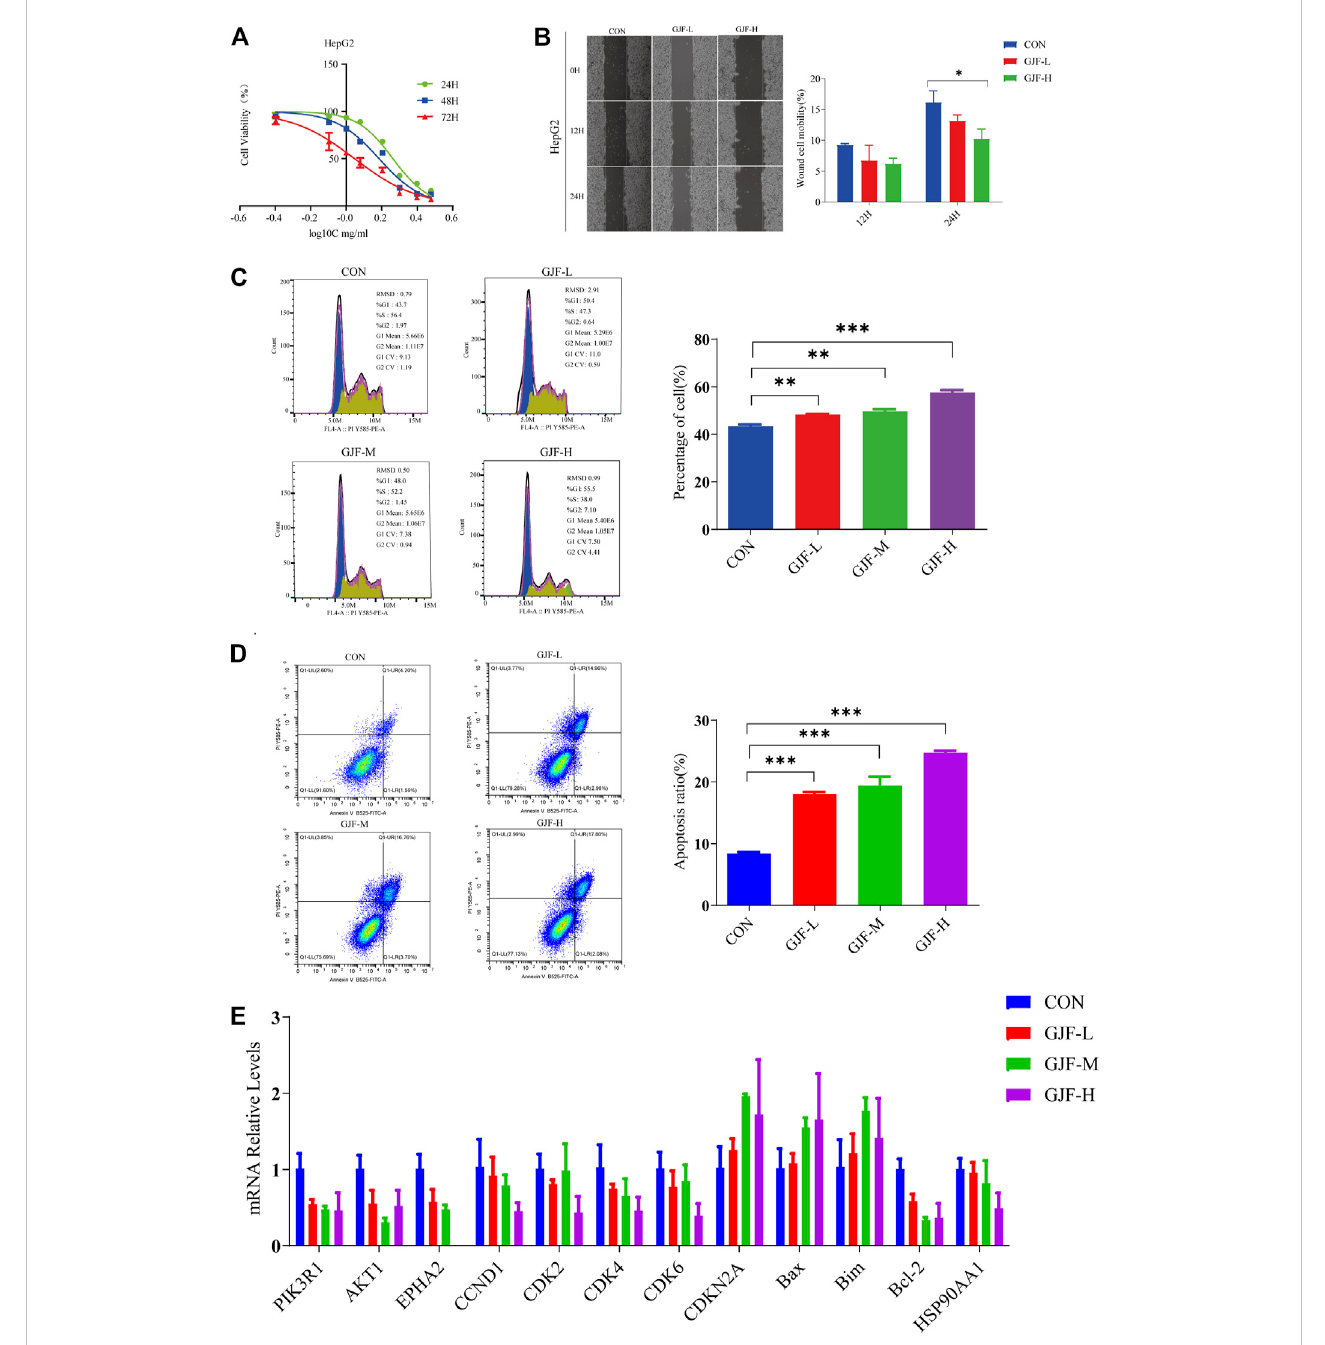
FIGURE 8 GJFinhibitedHepG2cellsgrowth invitro . (A) TheeffectofGJFonthesurvivalrateofHepG2cells. (B) EffectofGJFonthecellmobilityofHepG2cells. (C) GJF induces hepatocellular arrest of HepG2 cells cycles. (D) GJF induces apoptosis in HepG2 cells. (E) Changes in the mRNA expression levels of related molecules in the PI3K/Akt pathway in HepG2 cell lines. Gene expression was evaluated by RT-qPCR, using the 2 − ΔΔ CT method. (CON, negative control treatment; GJF-L, treated with low concentrations (0.5 mg/ml) of GJF; GJF-M, treated with medium concentrations (1.0 mg/ml) of GJF; GJF-H, treated with medium concentrations (1.5 mg/ml) of GJF. Data are presented as the mean ± SD, and analysis of variance was used to determine the signi fi cance. * p < 0.05; ** p < 0.01; *** p < 0.001 compared with the control